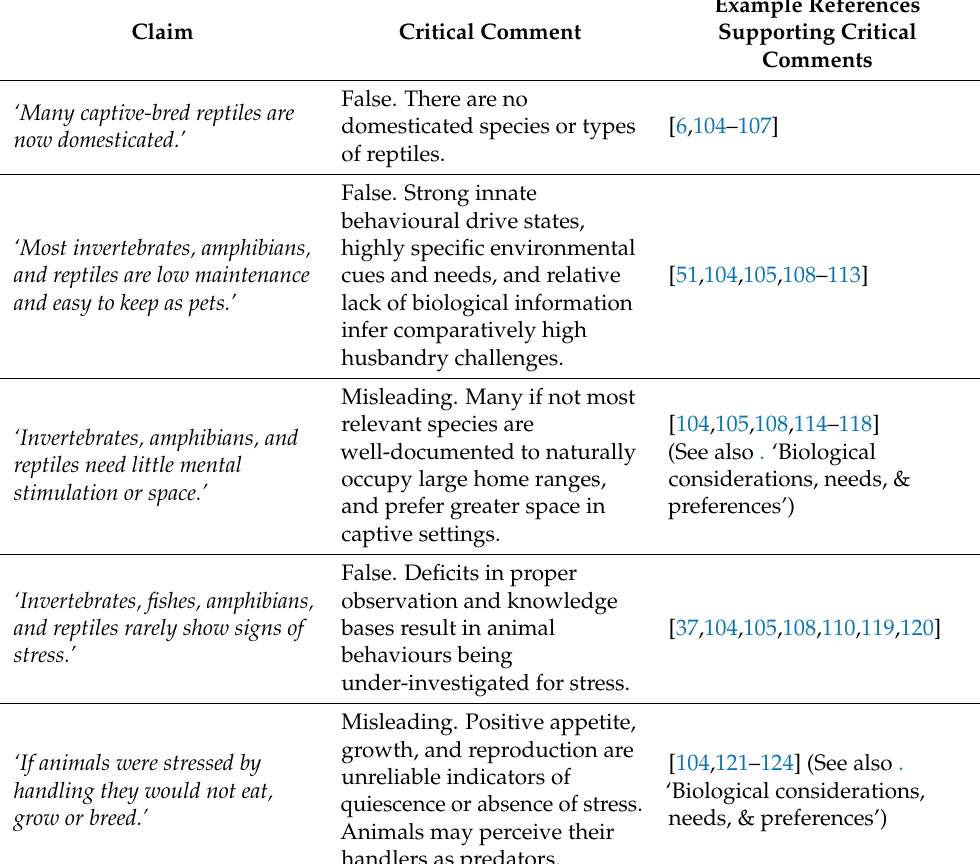
Table 9. Examples of common educational messaging (anonymised) associated with mobile zoos, and critical